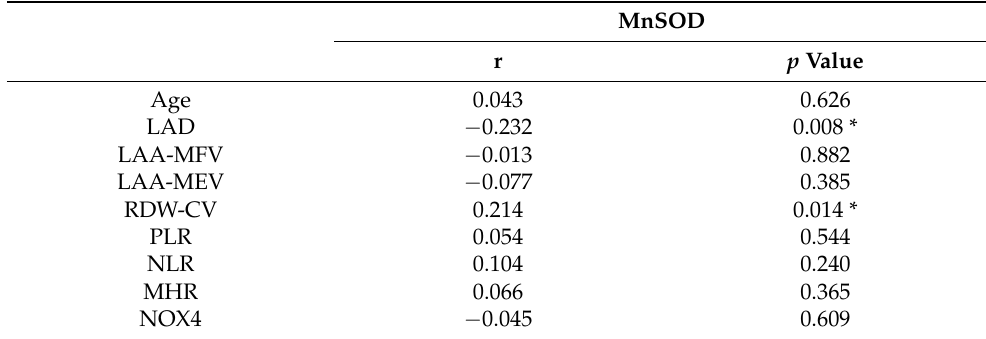
Table 5. Spearman correlation analysis of MnSOD with other